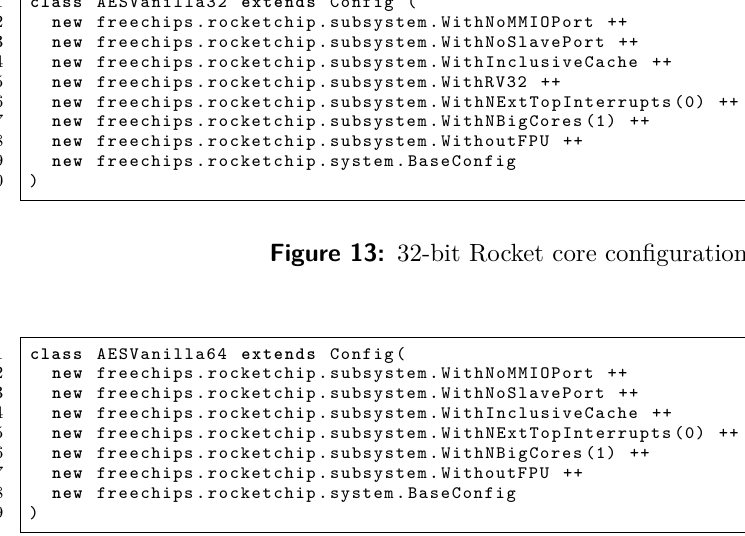
Figure 14: 64-bit Rocket core